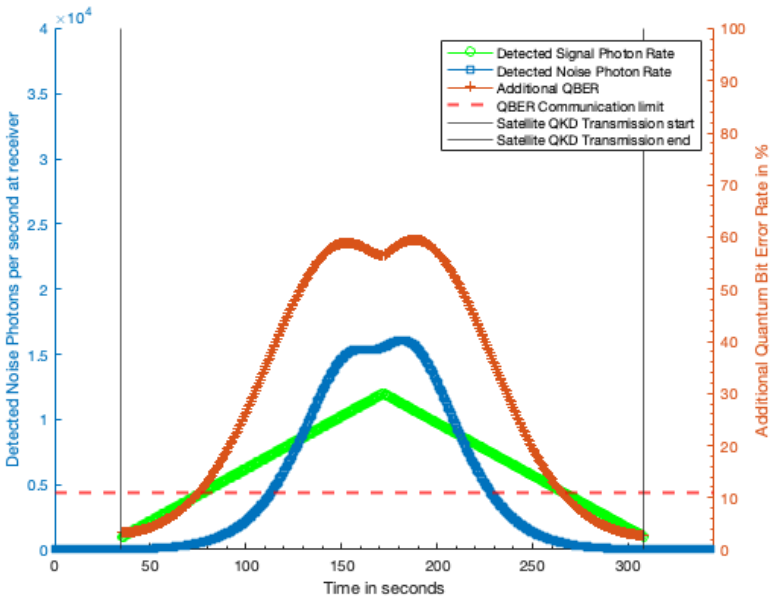
Figure 6. Additional QBER due to laser terminal with 10 cm optic from 100 km distance with 1 kW laser power. Green trace, detected QKD signal photon rate; blue trace, detected excess noise photon rate; red trace, additional QBER due to excess noise photons; dashed red line, QBER limit at which no secure key can be generated.